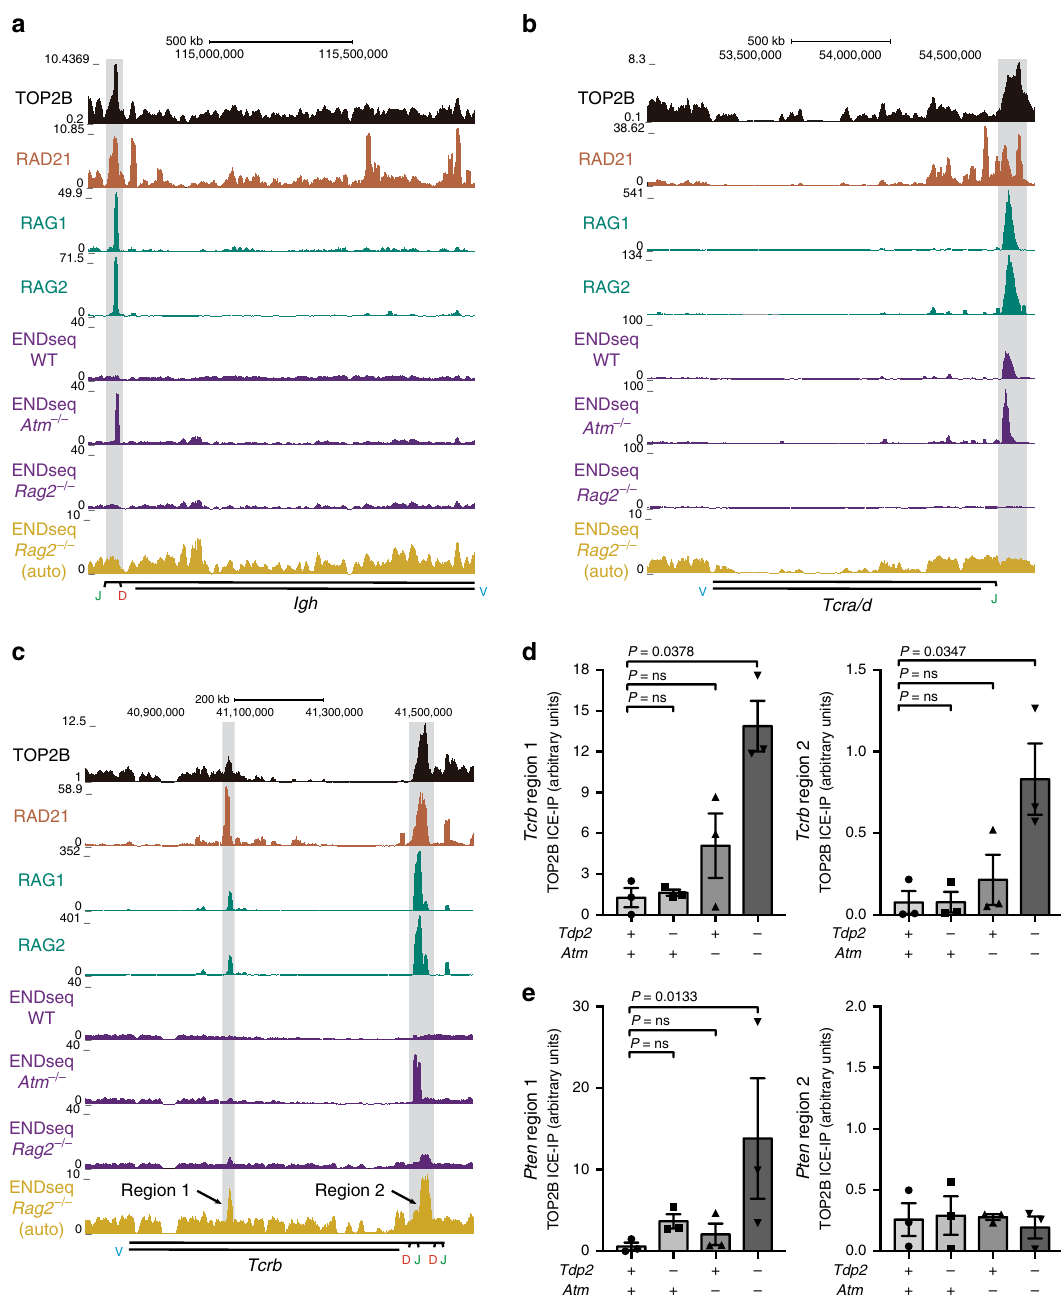
Fig. 7 TOP2B is enriched at V(D)J-active regions colocalizing with RAG and endogenous DSB accumulation. a – c Genome browser view of TOP2B, RAD21, RAG1, RAG2 and ENDseq signal tracks in wild-type, Atm − / − and Rag2 − / − primary thymocytes, as indicated, at IgH ( a ), Tcra / d ( b ) and Tcrb ( c ) loci. TOP2B enriched regions are highlighted in grey. Regions of V, D or J segments are indicated. ENDseq signal in Rag2 − / − thymocytes is additionally shown with a smaller scale to appreciate sites of minor DSB accumulation (yellow, auto). d , e Endogenous accumulation of TOP2Bccs and TOP2-mediated DSBs, as measured with ICE-IP, at Tcrb ( d ) and Pten ( e ) loci in Tdp2 + / + Atm + / + , Tdp2 − / − Atm + / + , Tdp2 + / + Atm − / − and Tdp2 − / − Atm − / − freshly isolated thymocytes from three independent mice ( n = 3). Regions 1 and 2 for Tcrb and Pten are indicated in Fig. 7c and 5c, respectively. Mean ± SEM and statistical signi fi cance by one-way ANOVA (non-parametric) with Dunn ’ s post-test is shown ( F = 9 for region 1 of Pten and F = 5,8 and F = 7 for region 1 and region 2 of Tcrb